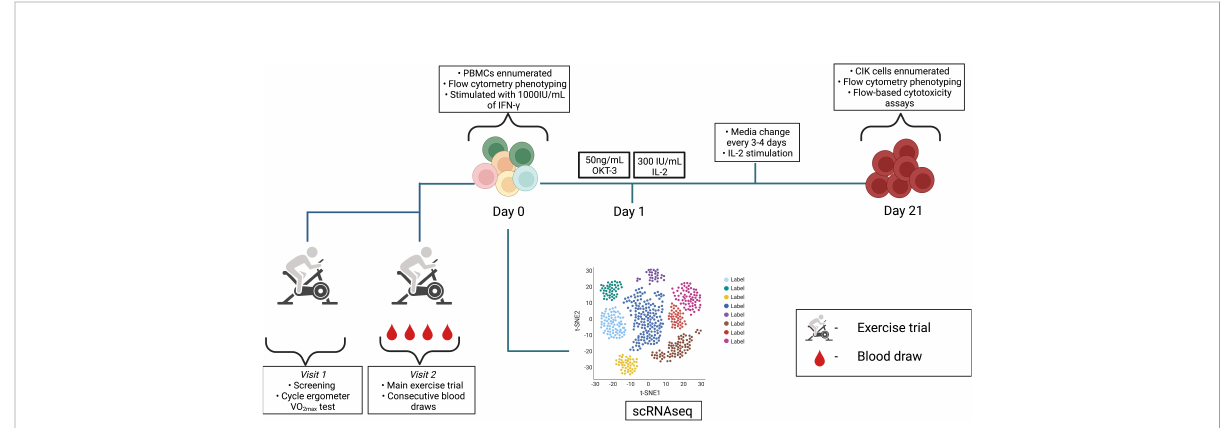
FIGURE 1 Schematic detailing the experimental design. Visit 1 and 2 consisted of exercise trials and serial blood draws were performed at rest, 60% VO 2max , 80% VO 2max , and +1H. PBMCs previously isolated from whole blood samples followed the CIK cell expansion protocol until day 21. scRNAseq was performed on resting PBMCs ( n = 3). Diagram was created with